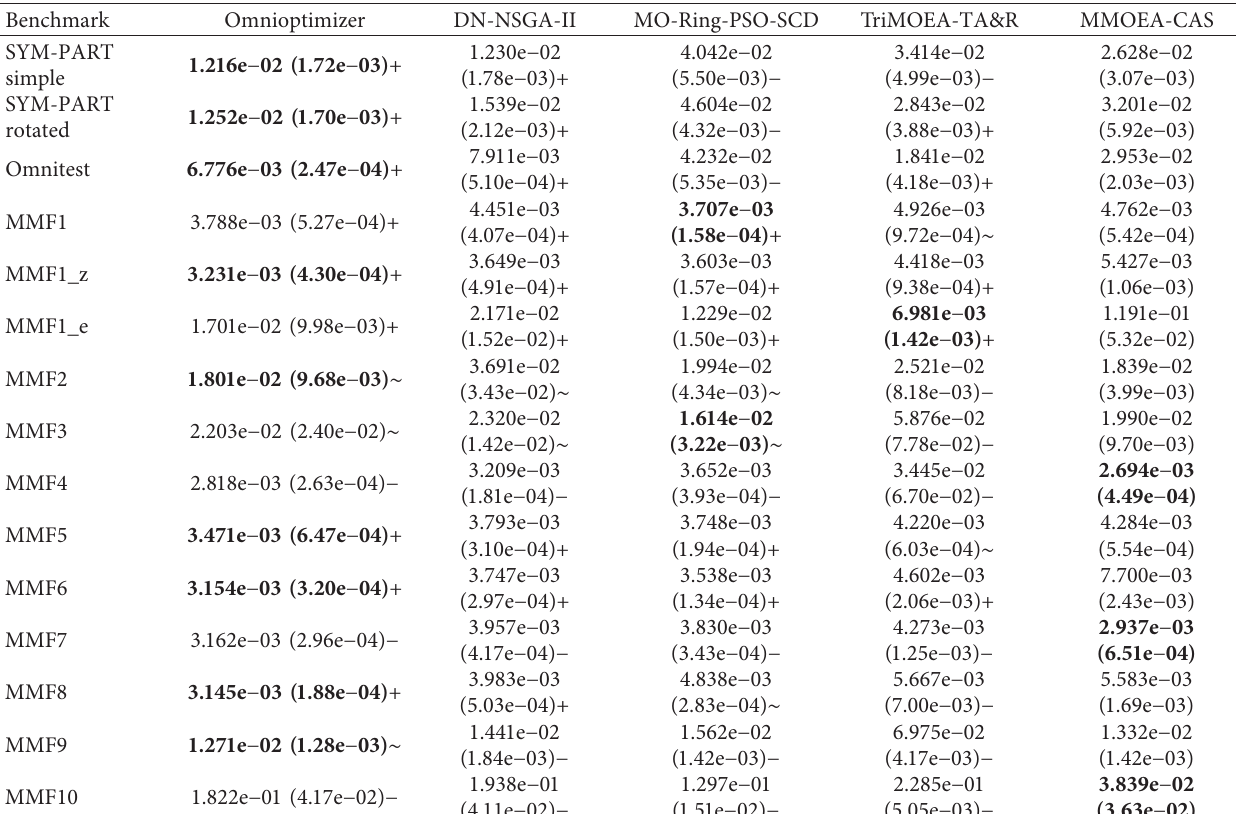
Table 4: Results obtained by four other MMOEAs and MMOEA-CAS on